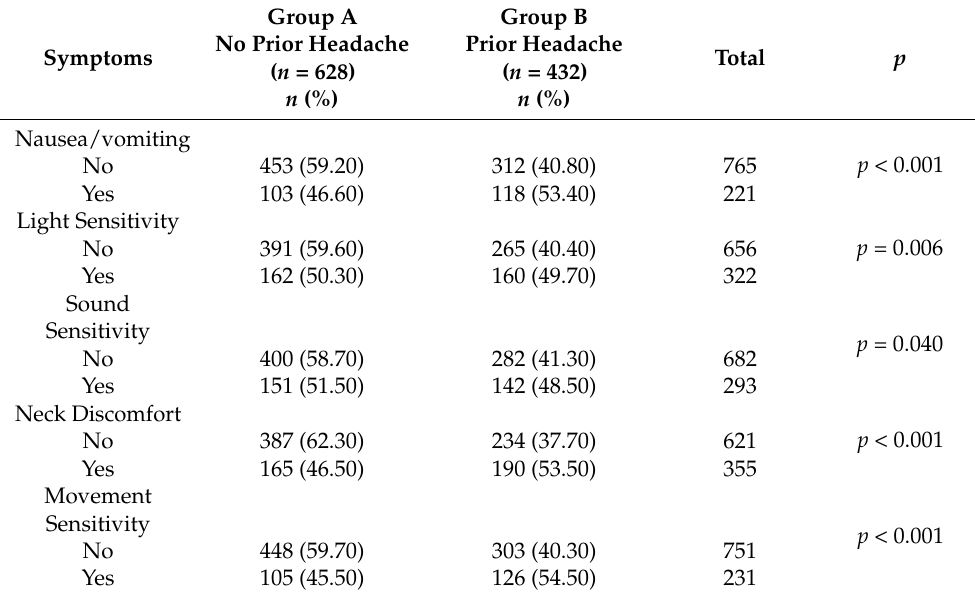
Table 6. Symptom Differences Among Healthcare Providers Who Experienced Headache using Chi Squared Test.